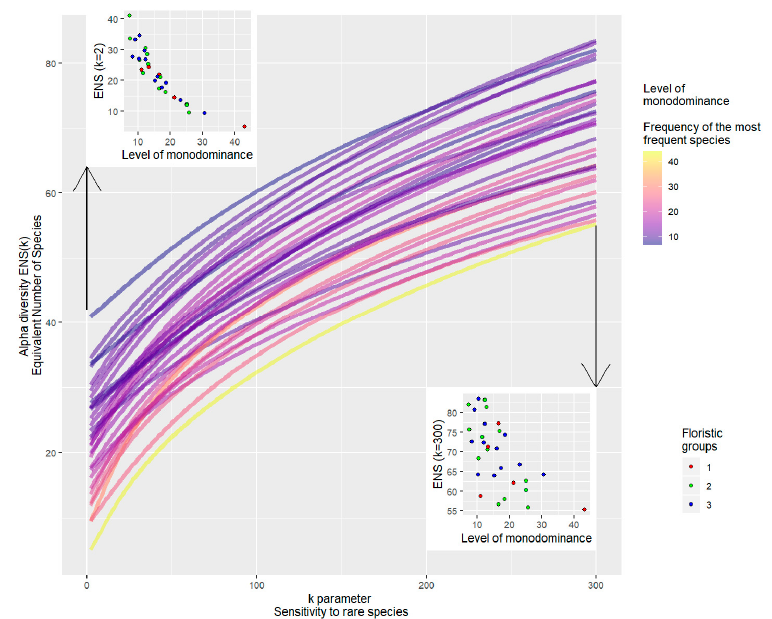
Figure 4. Individual-based rarefaction curves for the 30 plots expressed as equivalent number of species of the expected number of species in k randomly sampled individuals ENS k = 2 . Colors of the curves reflect the level of monodominance expressed as the frequency of the most frequent species. corner shows the relation between alpha diversity and the level of monodominance for ENS k = 2 thus being insensitive to rare species while the insert on the bottom right corner shows the relation between species. Colors of the dots in inserts correspond to the three floristic groups identified.